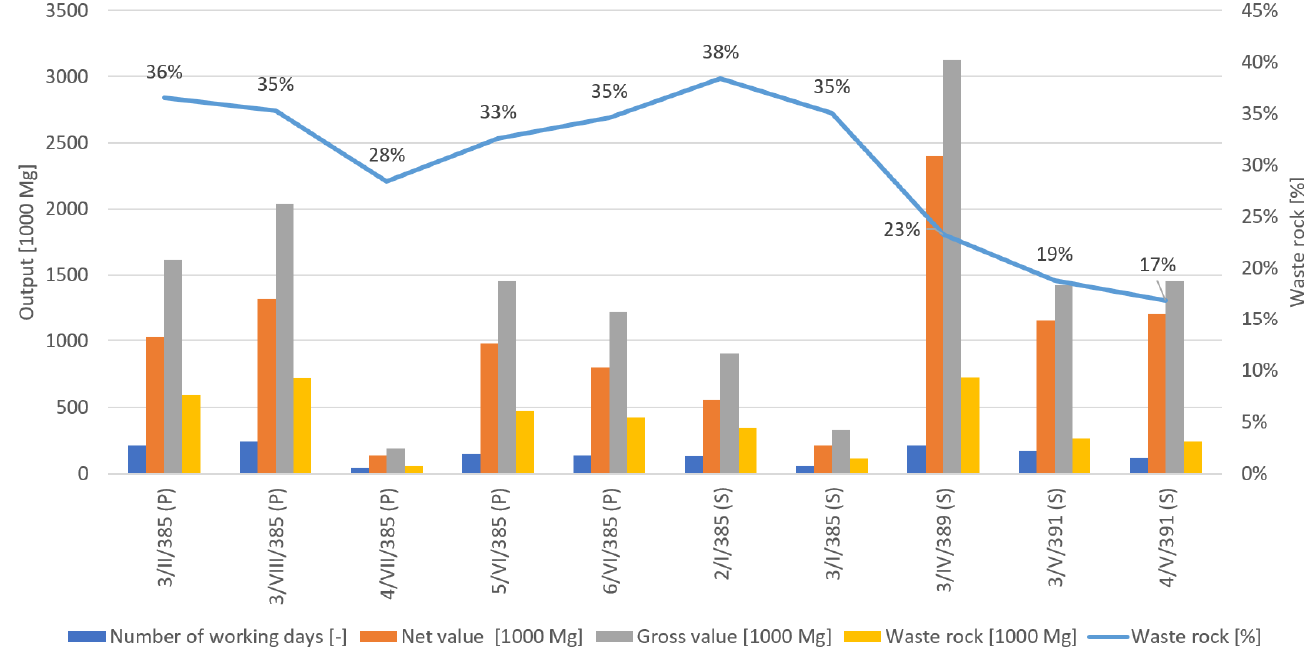
Figure 1. Total output and waste rock share for individual longwalls.